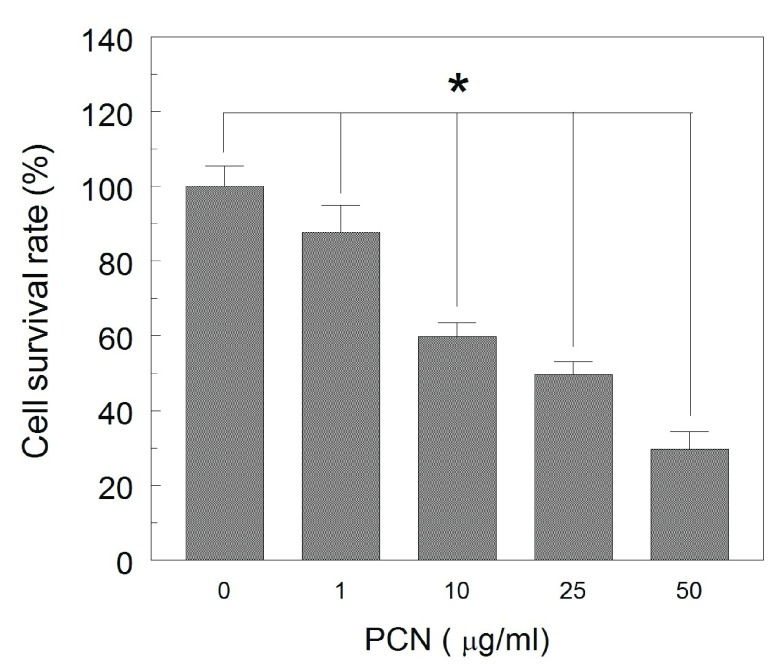
The effects of pyocyanin (PCN) on Raji cell survivability.After incubation with various concentration of PCN, Raji cell viabilities were assessed by MTT assay. PCN-treated Raji cell survivability was calculated against the control cells. *p<0.05.